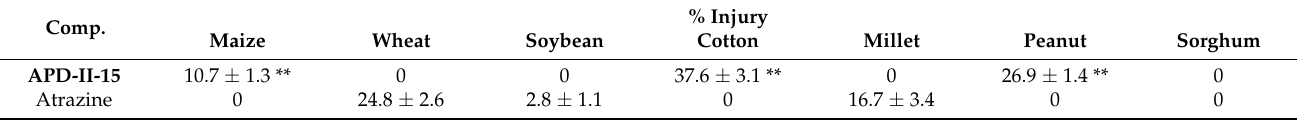
Table 1. Pre-emergence crop selectivity of APD-II-15 at the dosage of 375 g ha − 1 (Injury inhibition) a. Comp.